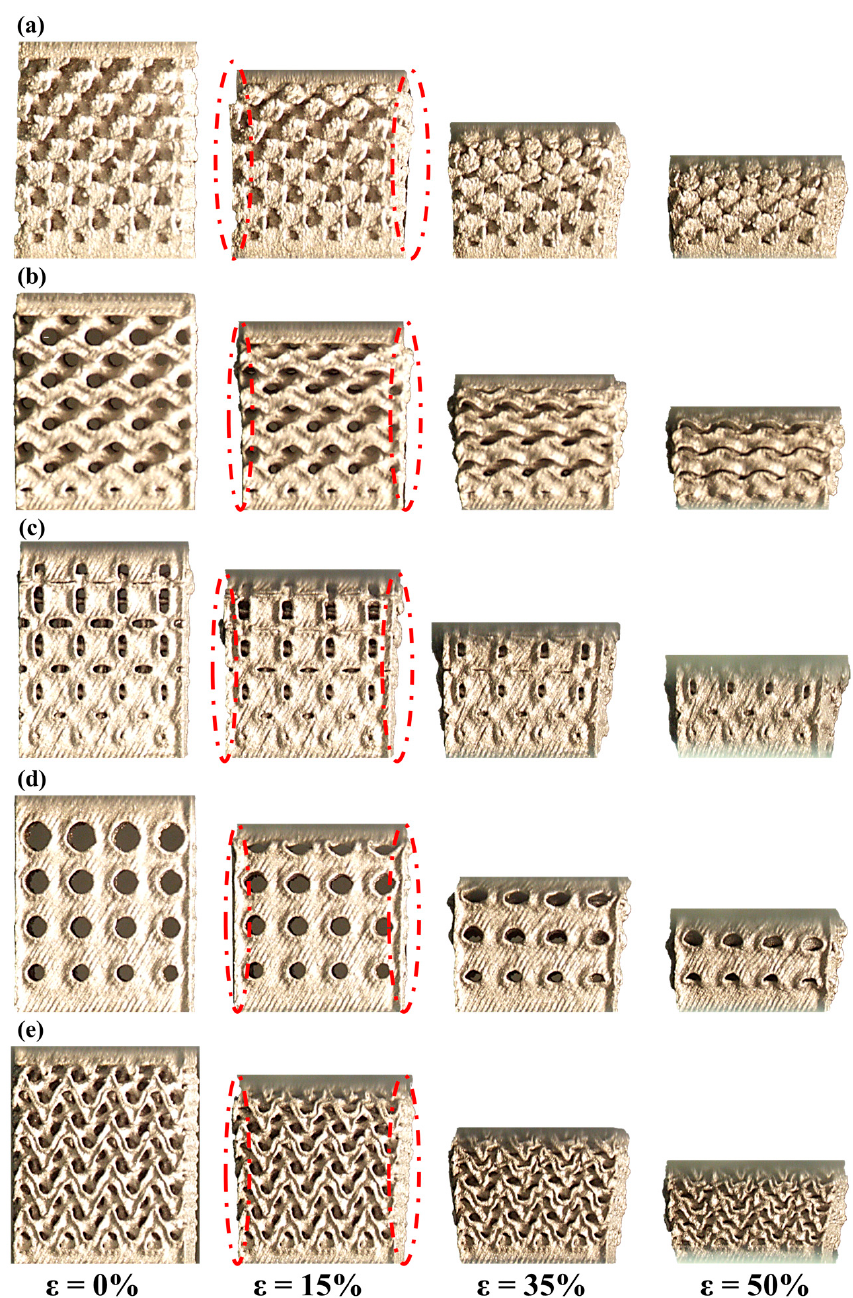
Figure 7. Images of ( a ) Diamond, ( b ) Gyroid, ( c ) Neovius, ( d ) Primitive, and ( e ) Fisher–Koch S TPMS structure recorded at different strains.